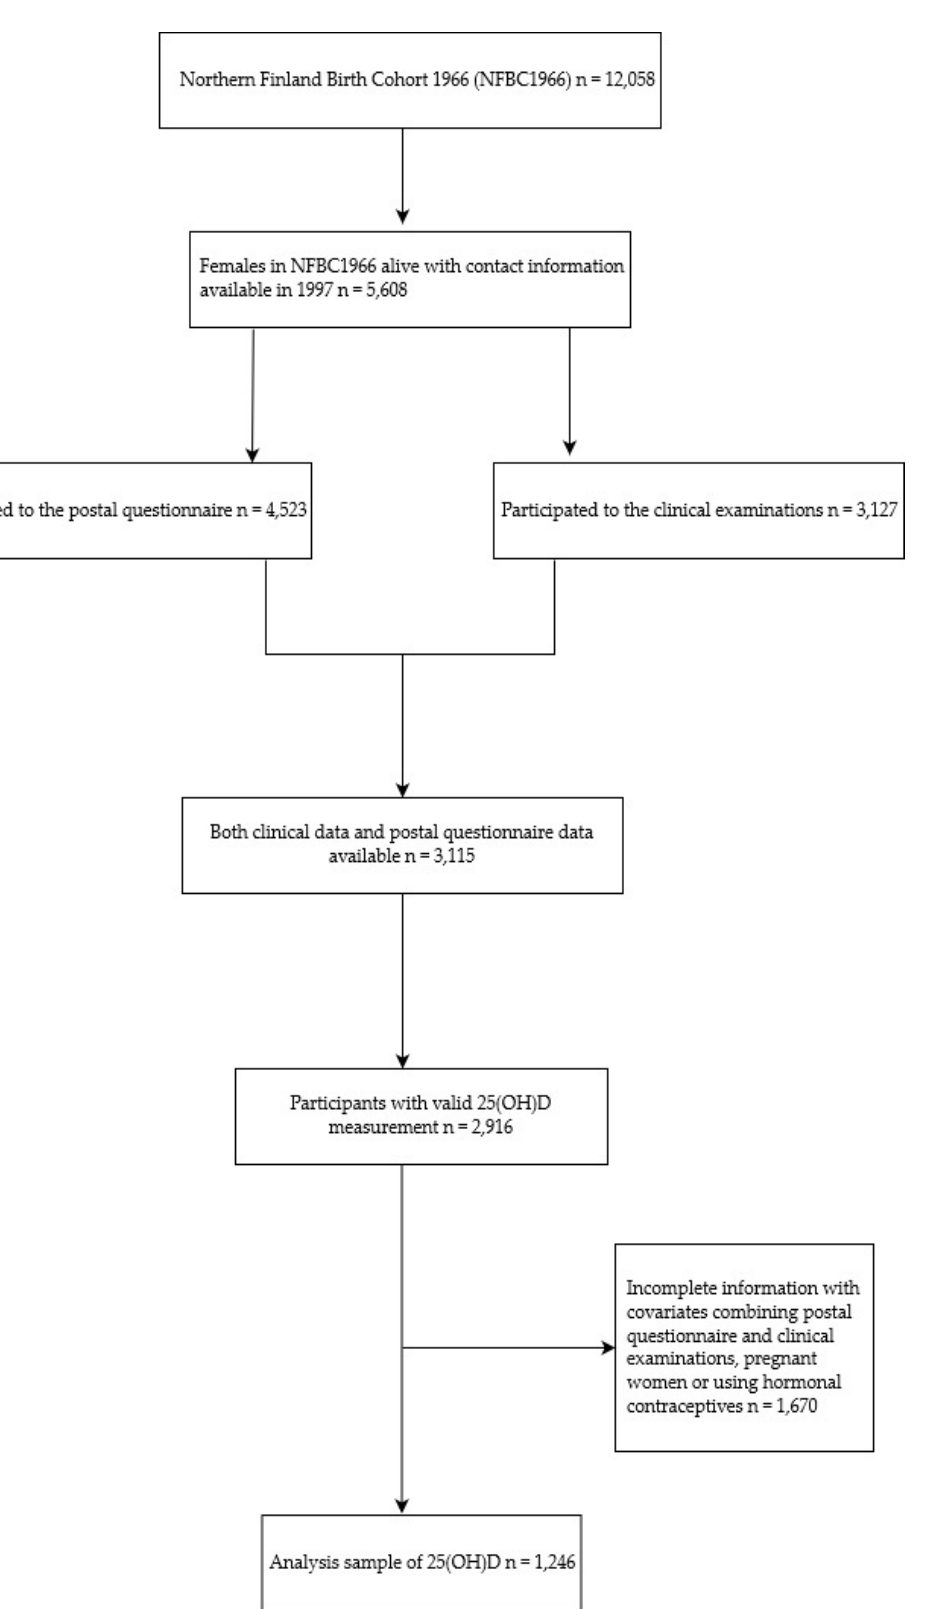
Figure 1. Flowchart showing the measured 25-hydroxyvitamin D (25(OH)D) samples in the female study population of the Northern Finland Birth Cohort 1966 (NFBC1966).